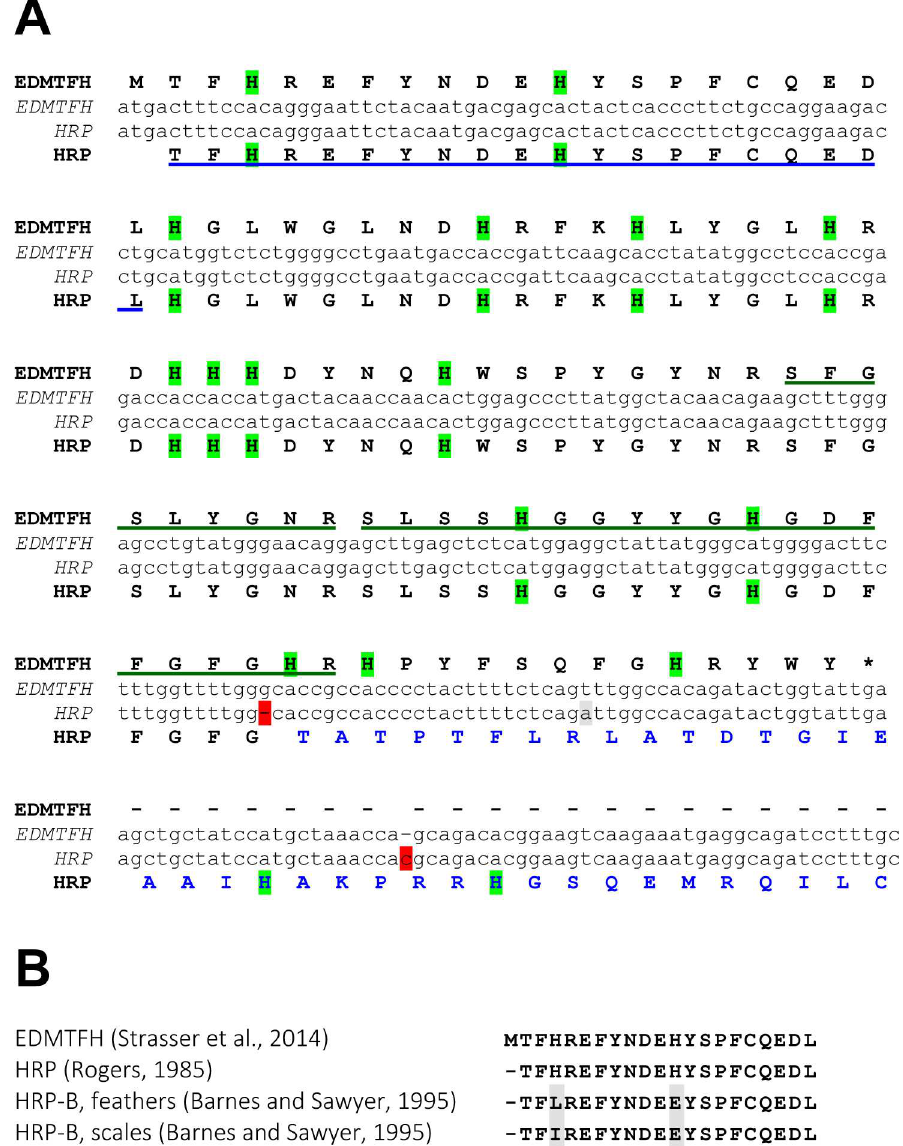
Fig 1. Nucleotide and amino acid sequence alignments of EDMTFH versus histidine-rich protein (HRP). ( A ) The nucleotidesequencesof the coding regionof chickenEDMTFH [13] and of the chicken HRP cDNA reportedpreviously[29] were aligned.Translationsinto amino acid sequencesare shown above and belowthe sequences,respectively.Note that insertions and deletions(red shading) in the cDNA sequence relativeto the chicken EDMTFH gene in the current genome assembly cause readingframeshifts leadingto the prediction of a different carboxy-terminus of HRP (blue fonts) relative to EDMTFH. Sequences corresponding to peptidesthat were previously identified in feather extracts are marked underlinedfeather proteinspeptides (underlined) correspondingto EDMTFH were identifiedby (blue underline[29], green underlines[13]). Histidine(H) residuesare highlightedby green shading. The stop codon of EDMTFH is marked with an asterisk. ( B ) Alignment of amino-terminal amino acid sequencesof EDMTFH [13] and HRP, as determinedby direct sequencing of proteins isolatedfrom feathers [29, 38]. Predicted HRP-B residues that deviatefrom the EDMTFH sequenceat positionsof histidines(H) are shaded